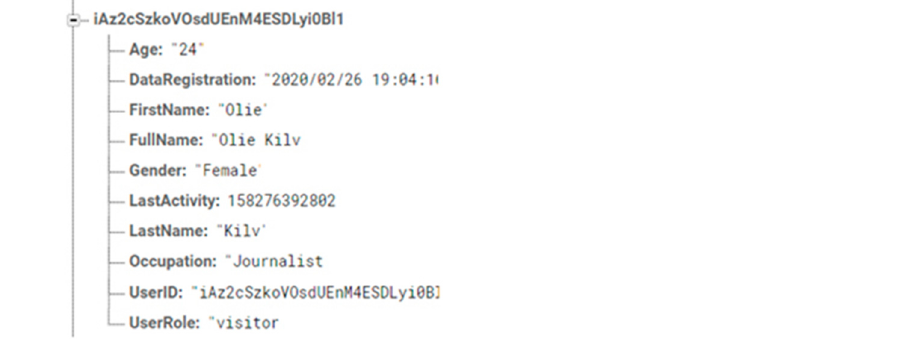
Figure 5. ARtful mobile app’s user profile data structure example stored in JSON format.